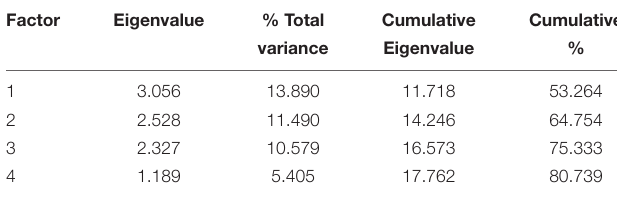
TABLE 2 | Parameters from PCA for the main four factors extracted.